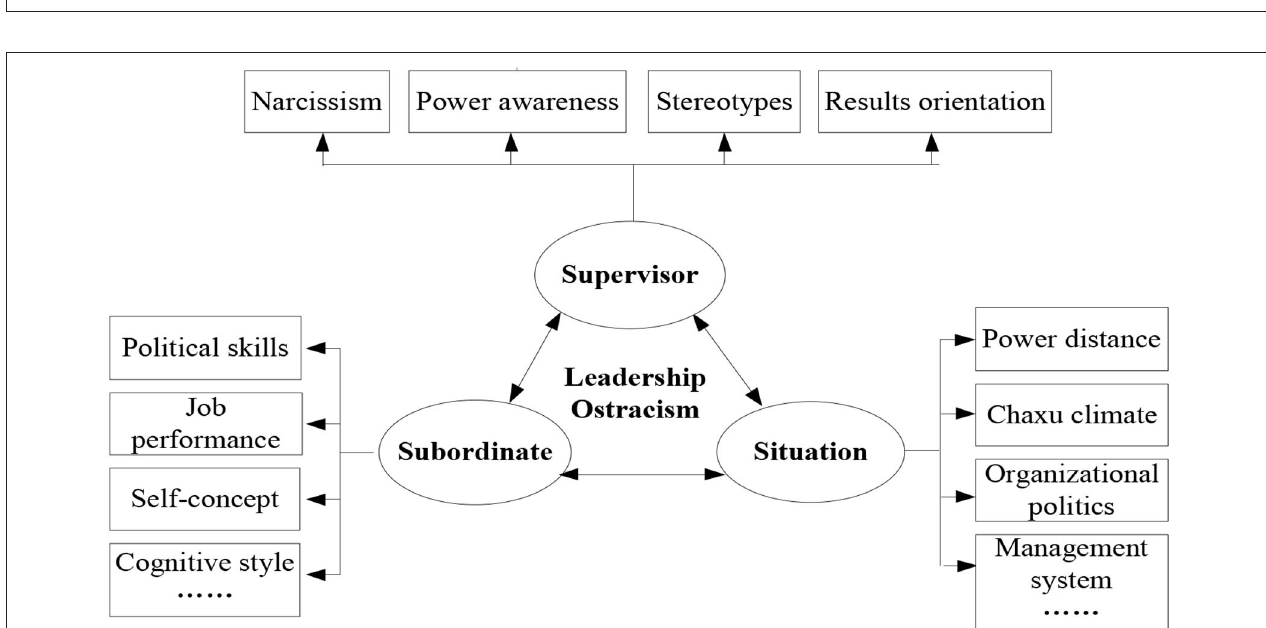
FIGURE 4 | The toxic triangle model of leadership